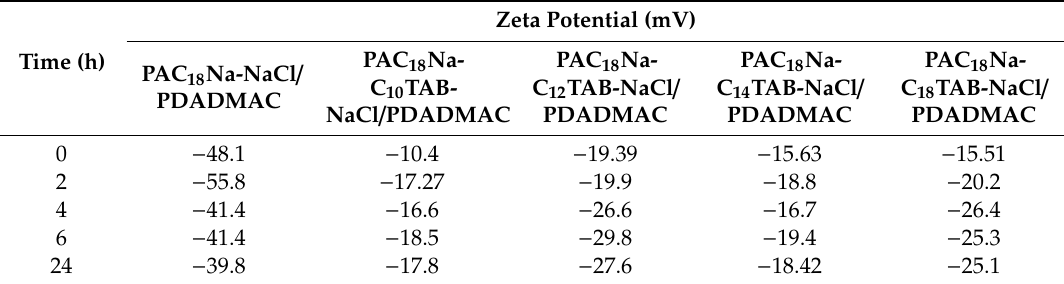
Table 2. Zeta potential data for several deposed